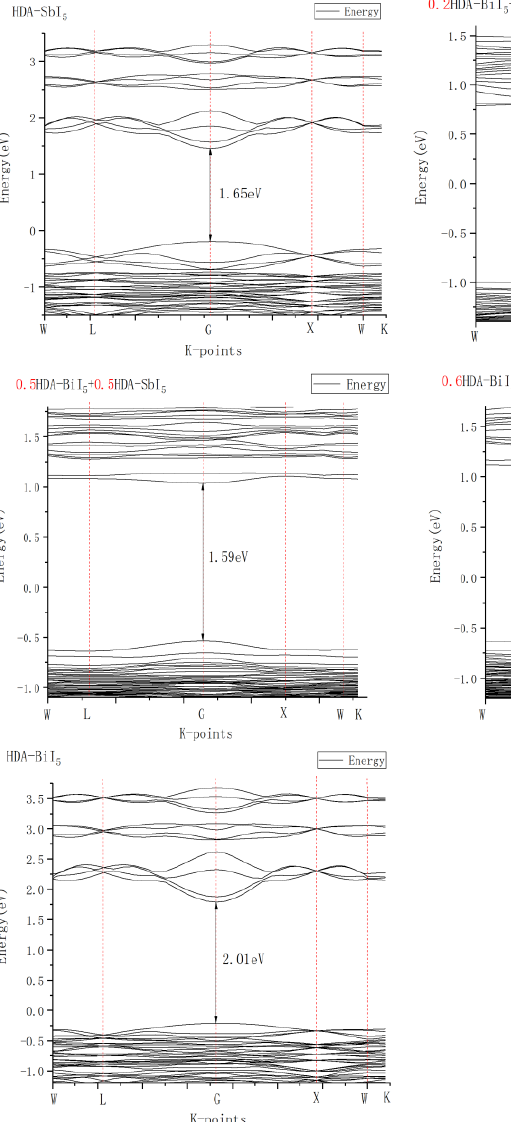
Figure 6. Theoretical calculated bandgap diagram of multicomponent ferroelectric